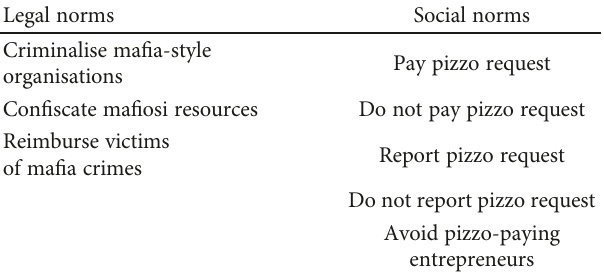
Table 1: Social and legal norms in the Palermo